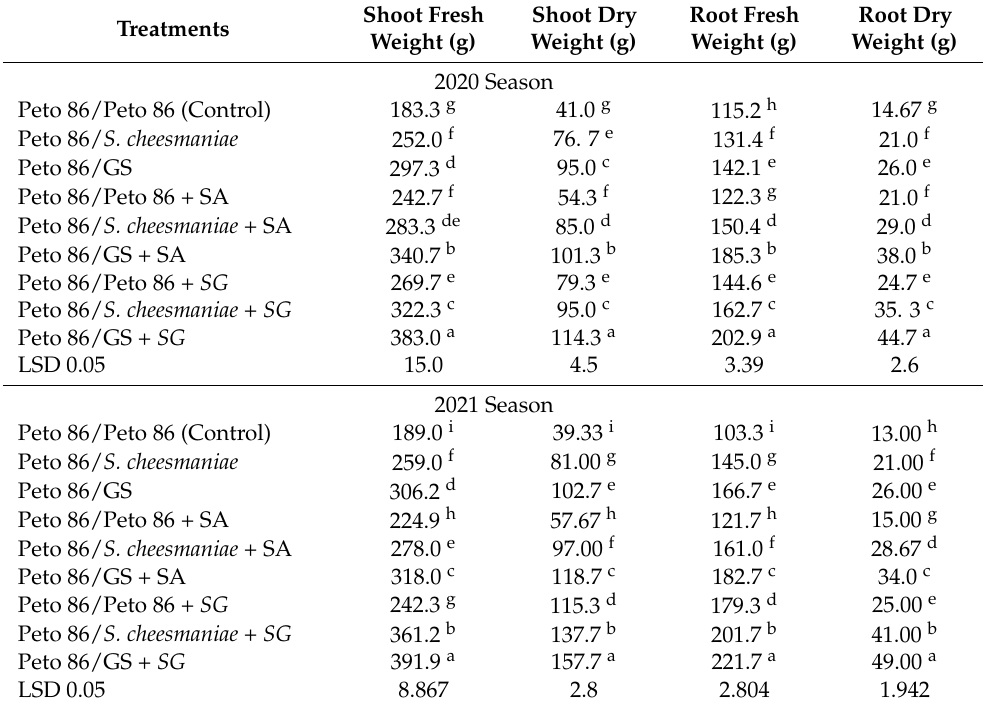
Table 2. Effects of grafting, seed priming with shikimic acid (SA), and colonisation with S. griseus (SG) on tomato plants growth during 2020 and 2021